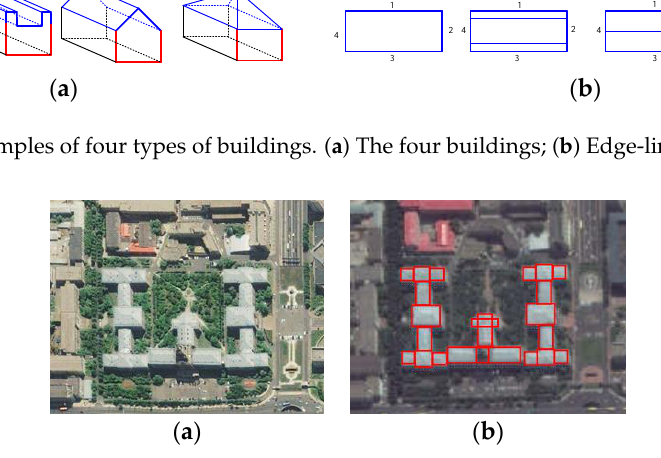
Figure 3. Blocks of an irregular top building. ( a ) An irregular top building; ( b ) Divided blocks.